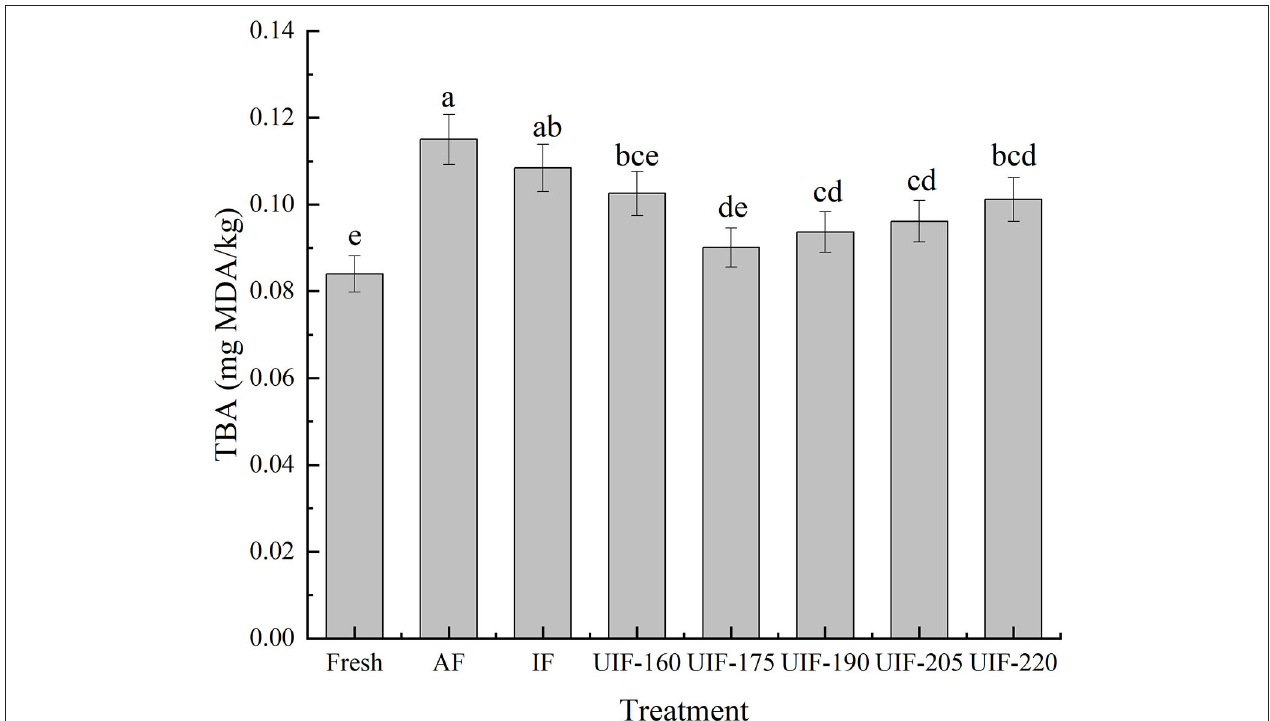
FIGURE 9 | Influence of different freezing treatments on the thiobarbituric acid reactive substances (TBARS) of large yellow croaker. The results are average ± standard deviation ( n = 3).